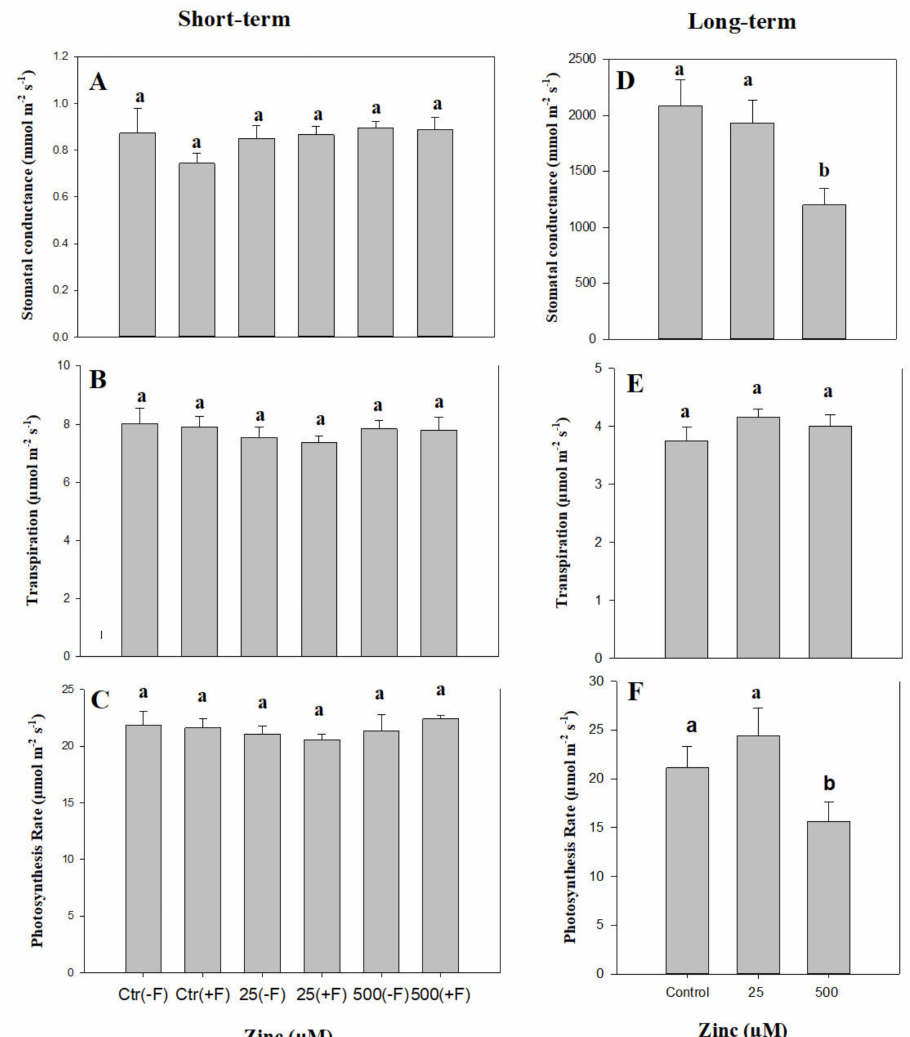
Figure 3. E ff ect of zinc concentration (0, 25 and 500 µ M) on gas exchange parameters of pak choi plants. After short-term application: ( A ) Stomatal conductance, ( B ) transpiration, ( C ) photosynthesis rate, where –F represents the measurements in the leaves that were not sprayed and + F represents the measurements in the leaves that were sprayed. After long-term application: ( D ) Stomatal conductance, ( E ) transpiration, ( F ) carbon assimilation. Values are means ± SE ( n = 5). Bars with di ff erent letters represent significant ( p < 0.05) di ff erences after ANOVA and an LSD (Least significant di ff erence)